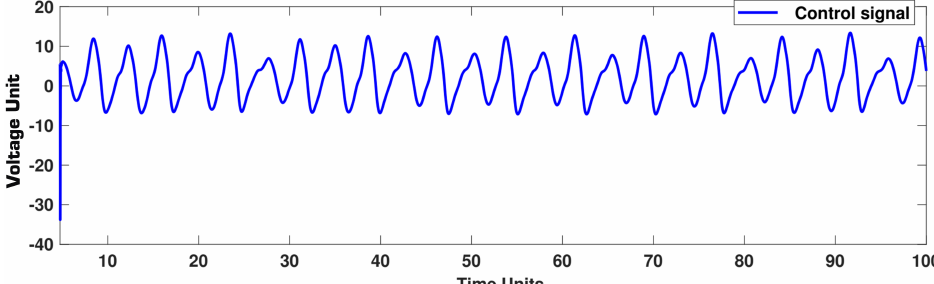
Figure 12. Example 3: Control signal.